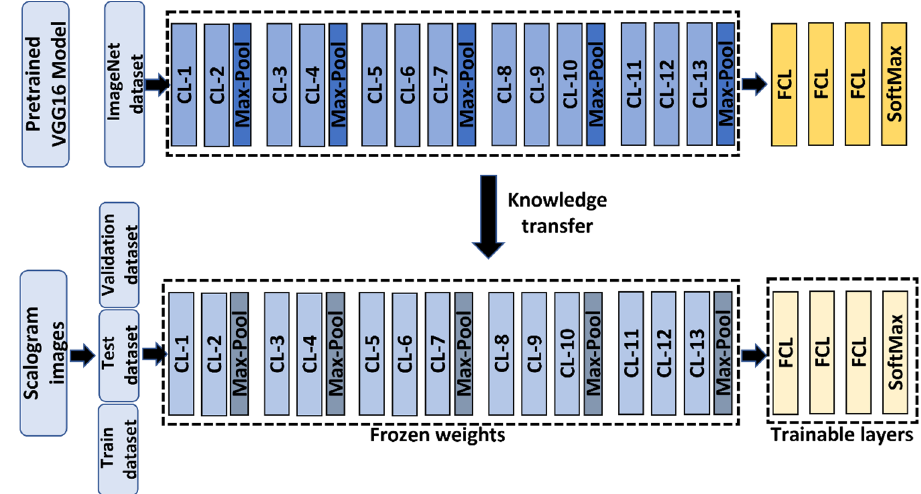
Figure 7. Block diagram of the proposed transfer learning-based fault detection model.